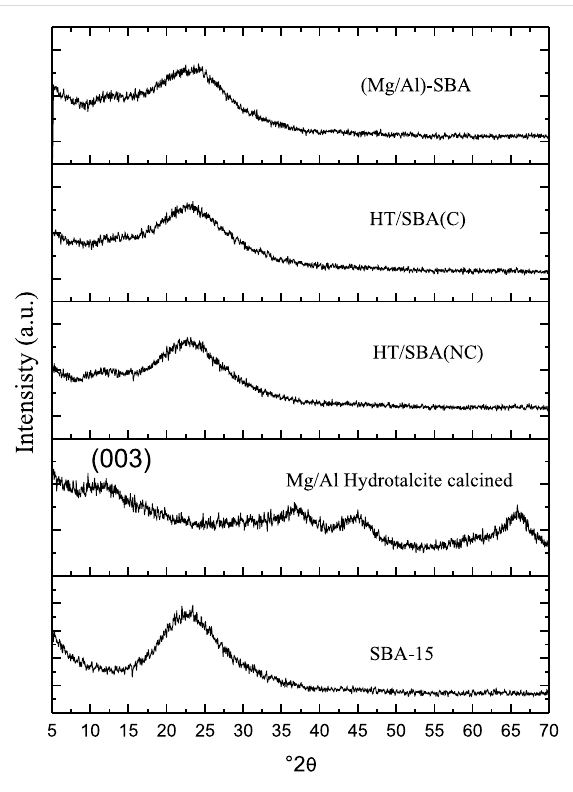
Figure 2: Diffractograms of X-ray of the composites, SBA-15 and